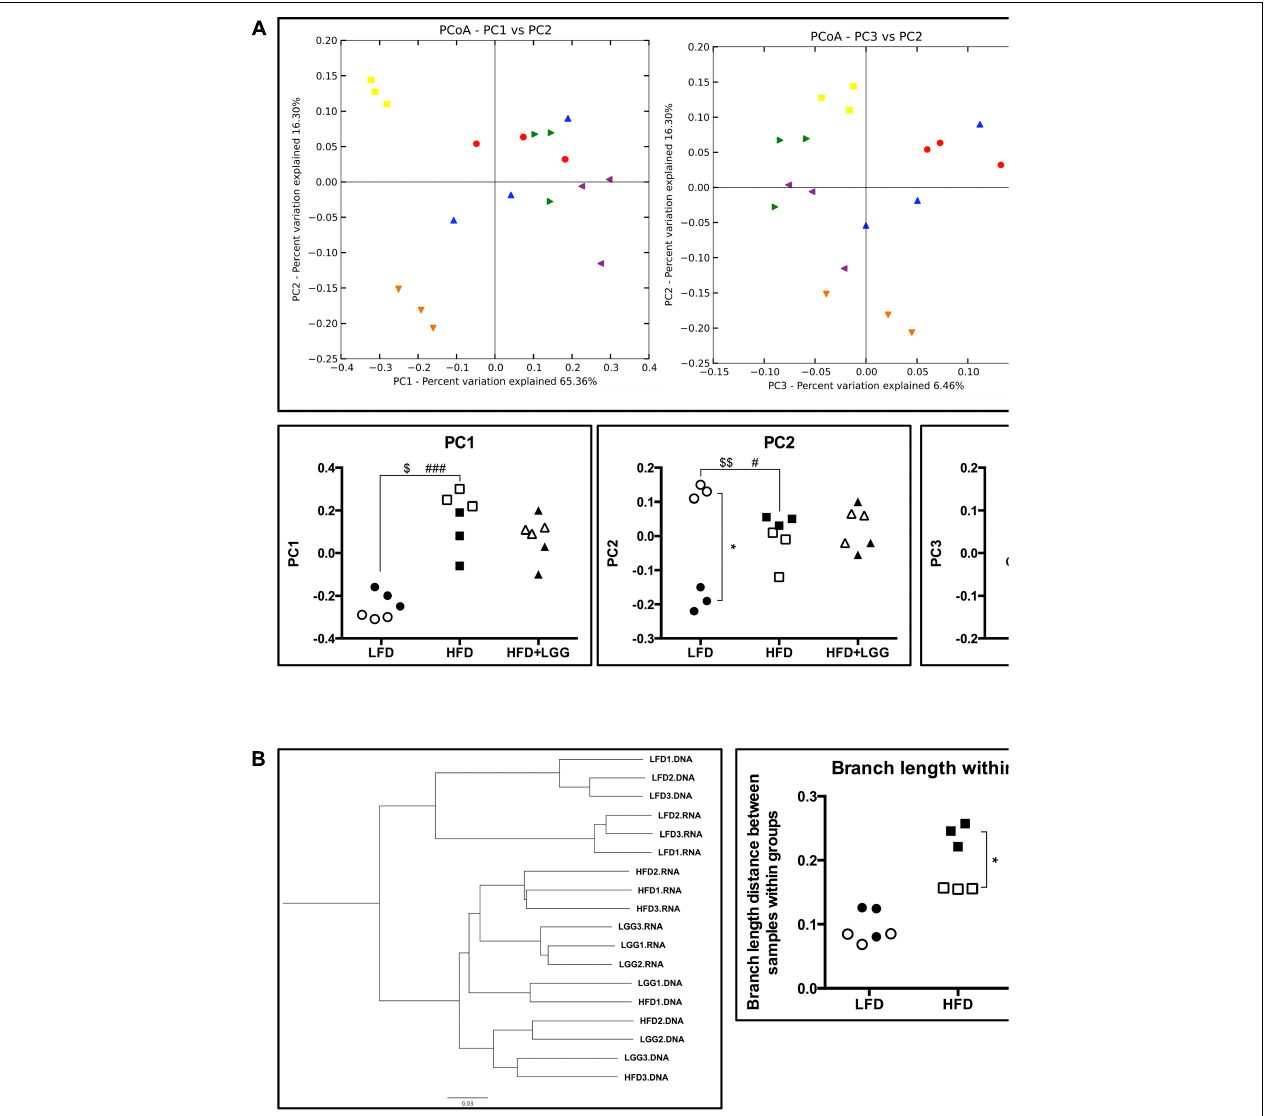
FIGURE 4 | Alpha- and beta-diversity of fecal microbiota in a murine DIO model. (A) Weighted principal coordinates analysis and value of each principal component dimensions; (B) weighted pair group method with averaging and calculated branch length of samples within each group. Significance level was calculated using ANOVA and Bonferroni’s multiple comparisons test; ∗ shows significant difference between DNA and RNA analysis, $ shows significant difference of LFD and HFD+LGG compared to HFD according to DNA analysis, and # shows significant difference of LFD and HFD+LGG compared to HFD according to RNA analysis. The level of significance is expressed by the number of symbols (one = < 0.05, two = < 0.01, three = <